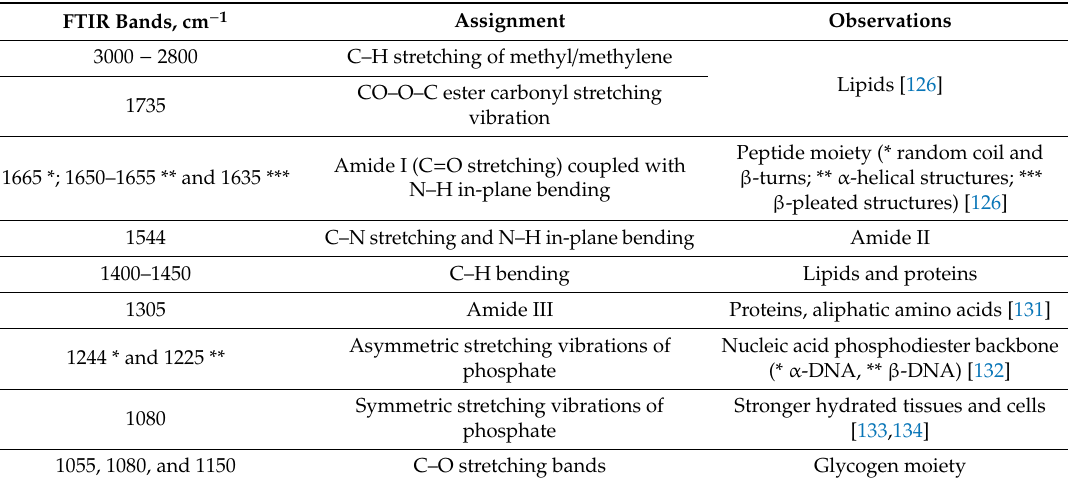
Table 5. The major bands assignments of an ectocervical